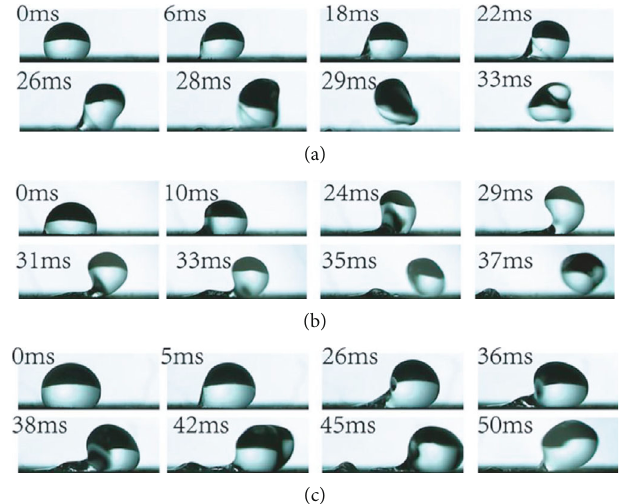
Figure 15: The movement of di ff erent volume droplets on GDL surface at air velocity of 5 m/s.